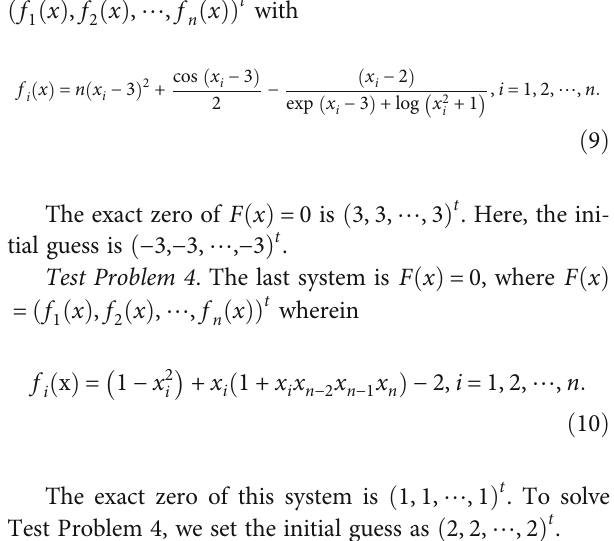
algorithm solely. The di ff erent categories of nonlinear solvers are the fi rst reason. Existing di ff erent parameters in any algorithm is the second one. Further,